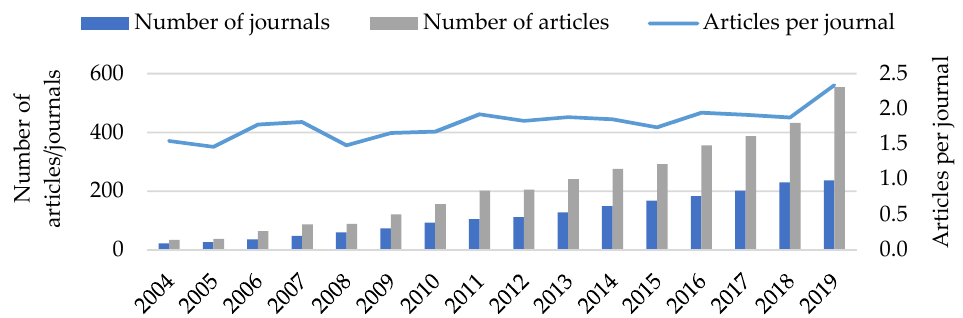
Figure 1. Number of articles and journals. Source: Authors; N = 3534.